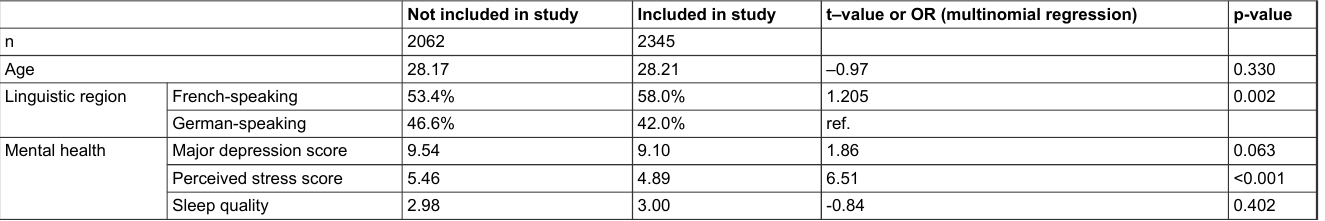
Depression without baseline adjustment